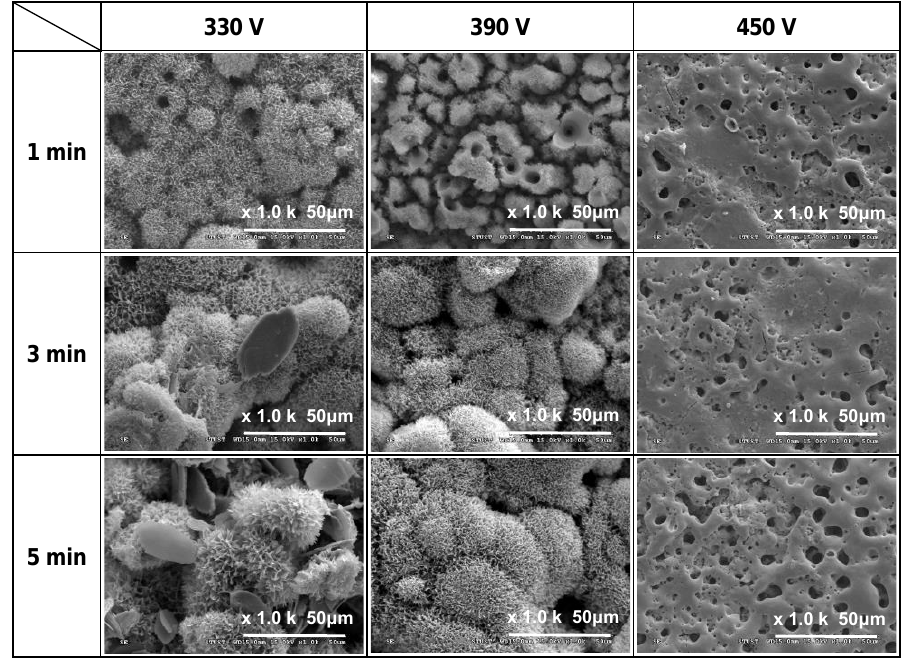
Figure 2. Surface morphologies of MAO coatings prepared with different applied voltages and duration times and constant applied current of 0.5 A.